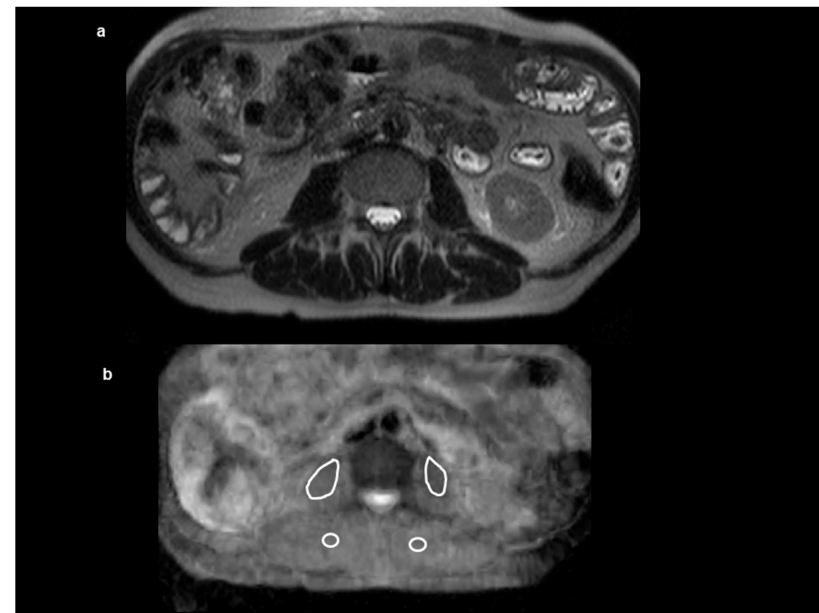
Figure 2. Anatomical sequence T2 weighted (T2w) at the level L2/3 ( a ). Apparent diffusion coefficient map ( b ) at the same level with the regions of interest within the skeletal musculature.